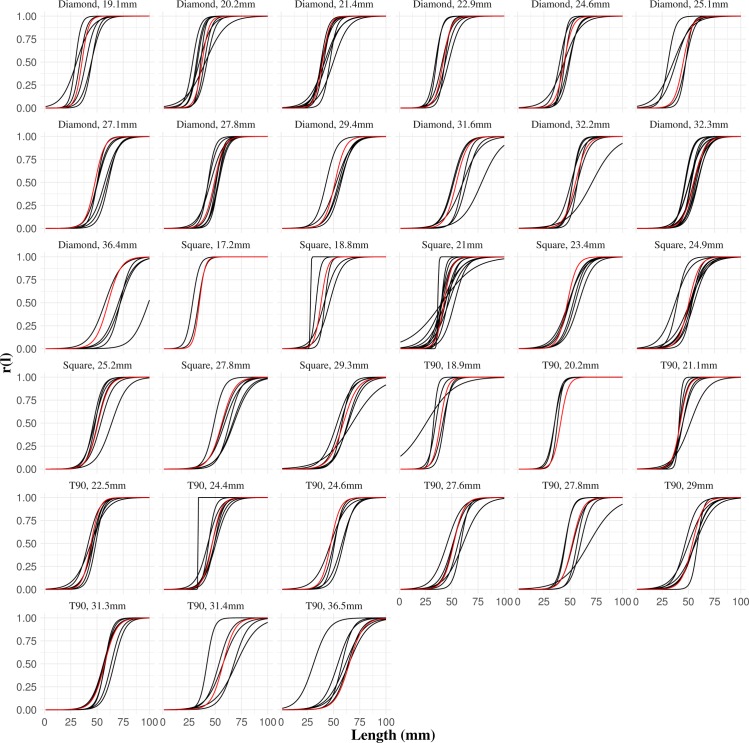
Predicted size selection curves for each of the experimental codends.For visual comparison, the mean curves predicted by the selected models (red lines) for each codend are plotted together with the size selection curves obtained experimentally (black lines).